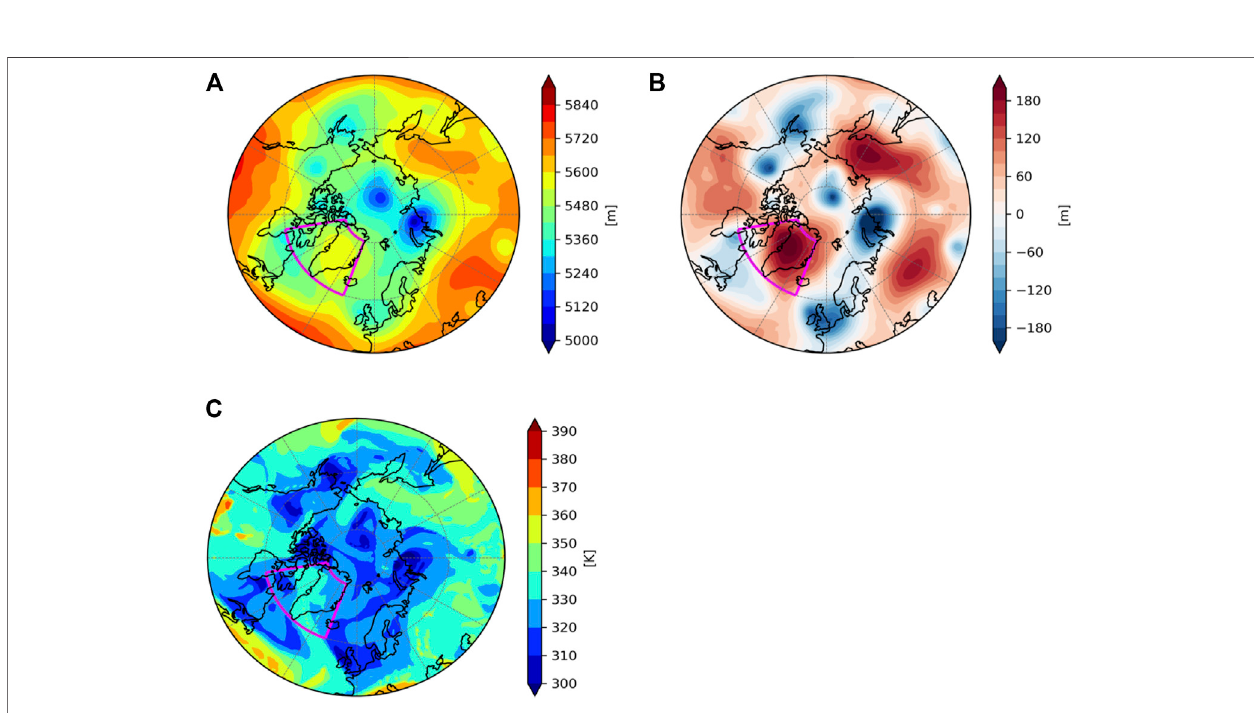
FIGURE 2 | A Greenland blocking event on July 11, 2012 seen in (A) 500 hPa height, (B) 500 hPa height anomalies compared with the 1981 – 2010 JJA climatology, and (C) potential temperature at 2PVU. The box corresponds to the spatial extent of the GBI boundary, from Wachowicz et al. (2021).